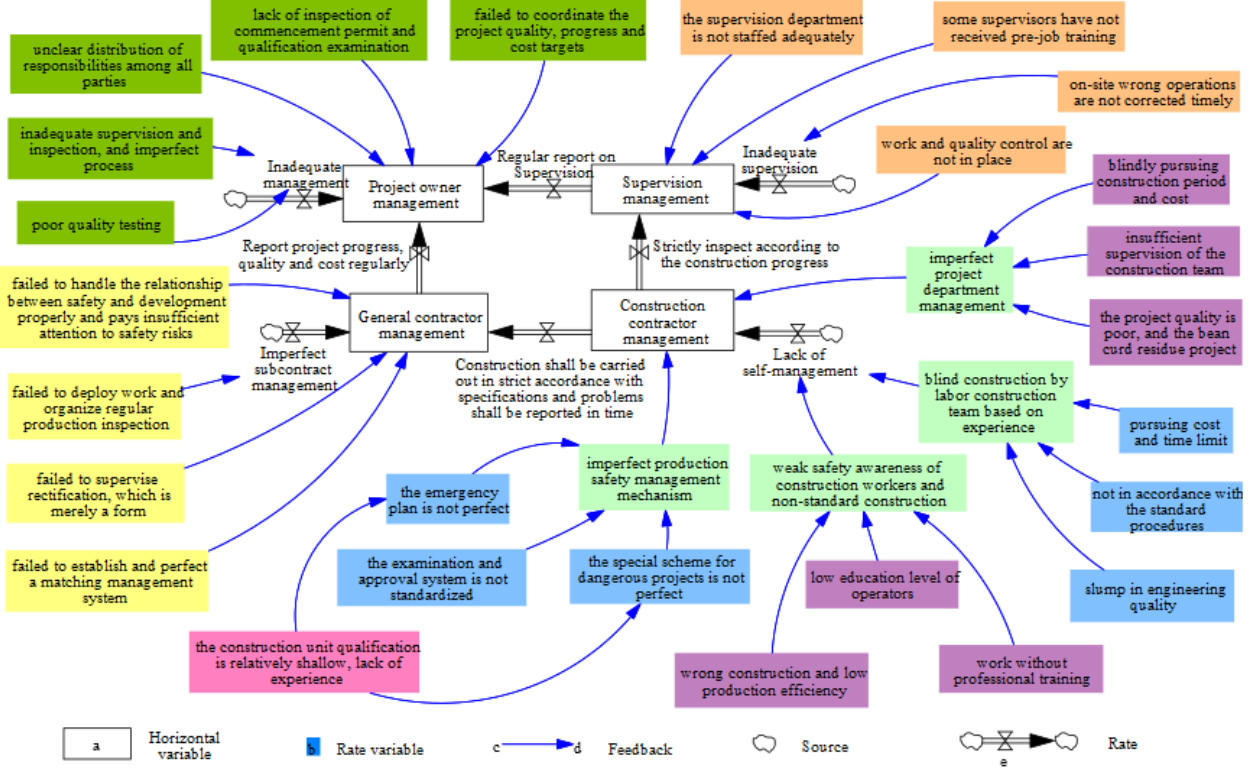
Figure 7. Dynamic evolution of the management factor system in the FPCA.